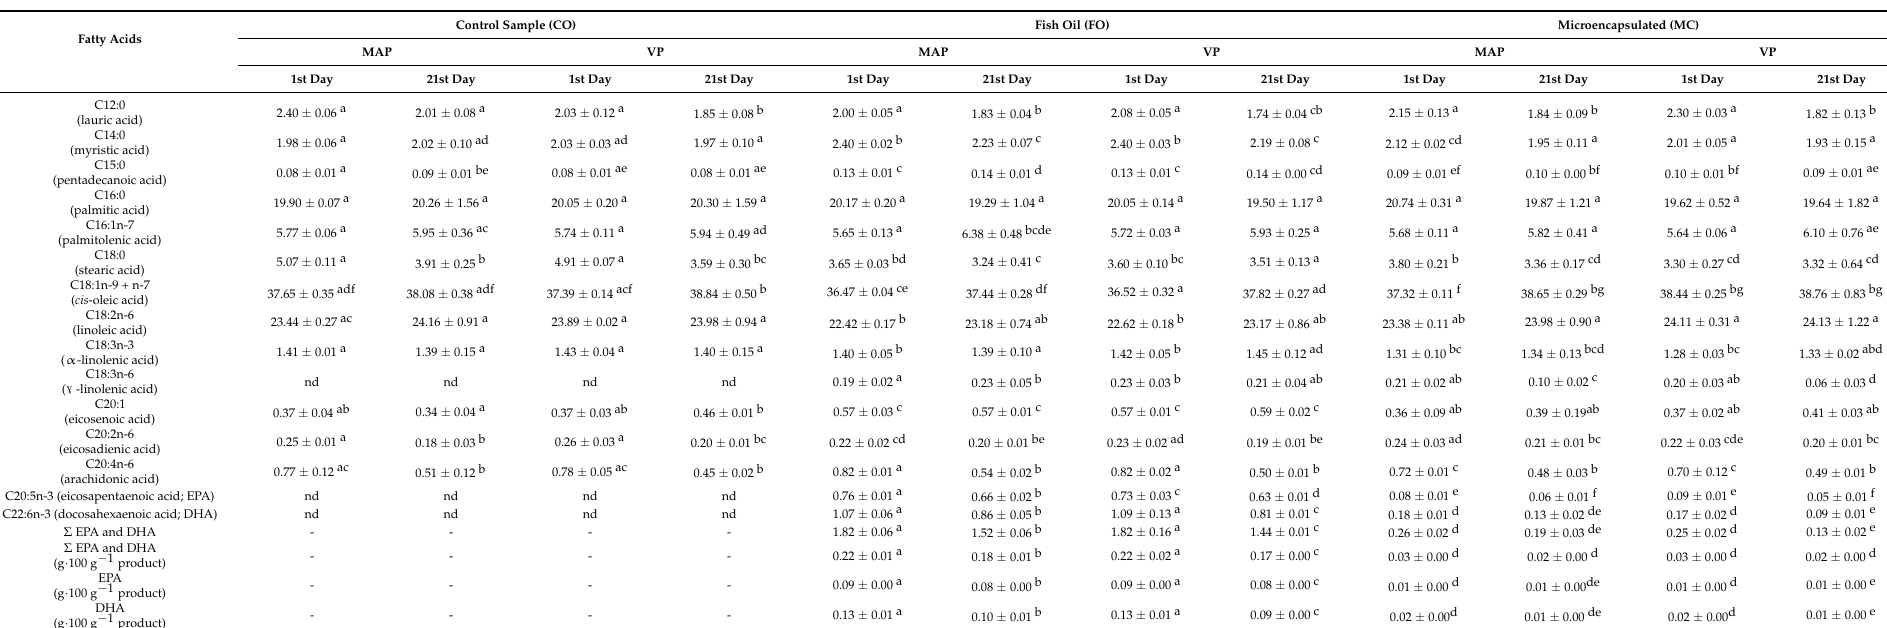
Table 3. The profile of fatty acids in the poultry sausages with the liquid and microencapsulated fish oil additive depending on the packaging method (vacuum-packed-VP or modified-atmosphere-packed-MAP) and storage duration. Control Sample Fatty Acids